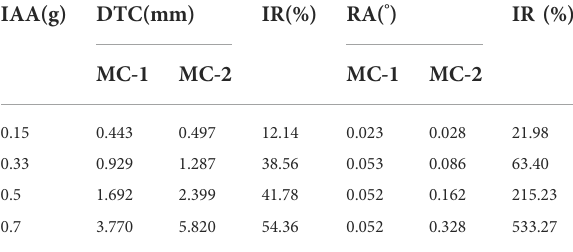
TABLE 5 Displacement of top container 5# and increase range with different moisture